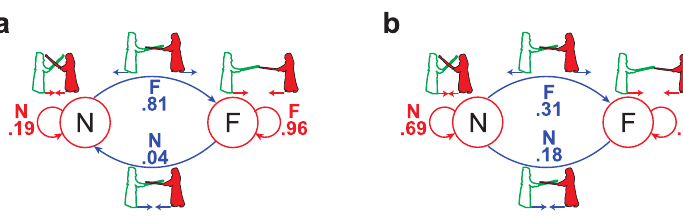
Figure 5. Second-order state transition diagrams with conditional probabilities consisting of the “farthest apart” high velocity states (F) and the “nearest together” low velocity state (N) for expert ( a ) and intermediate ( b ) competitors, respectively. Modified from